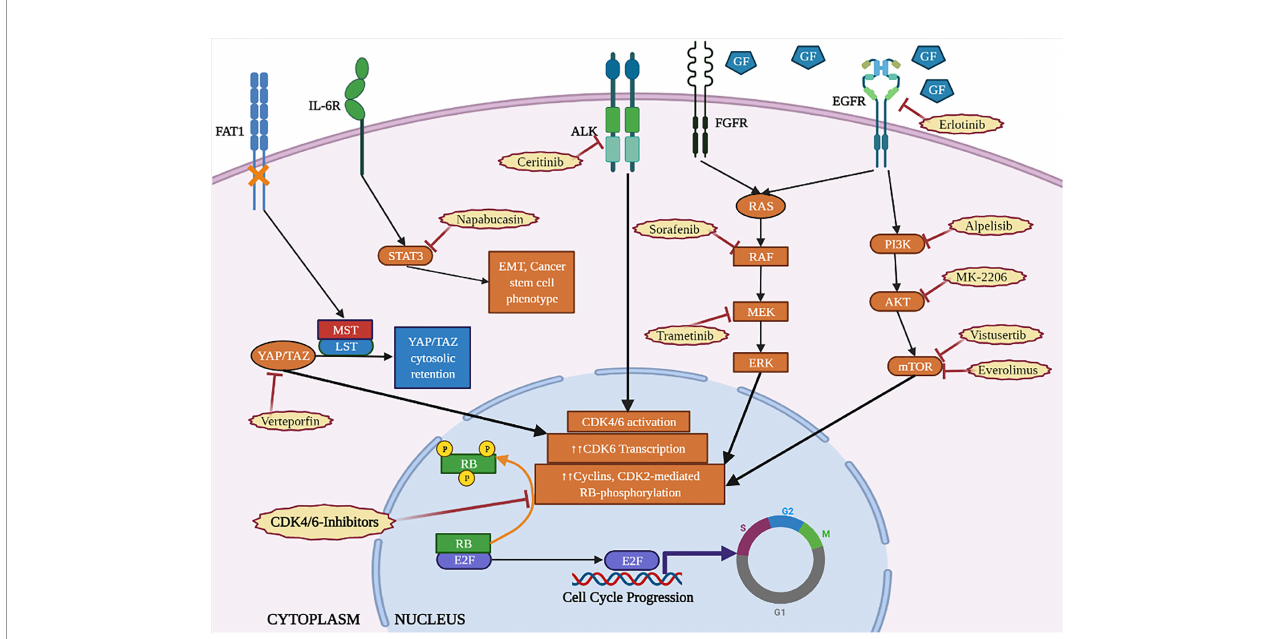
FIGURE 3 | Cytoplasmic cascades involved in the resistance to CDK4/6-inhibitors (orange) and targeted therapies to counteract them (red). Created with